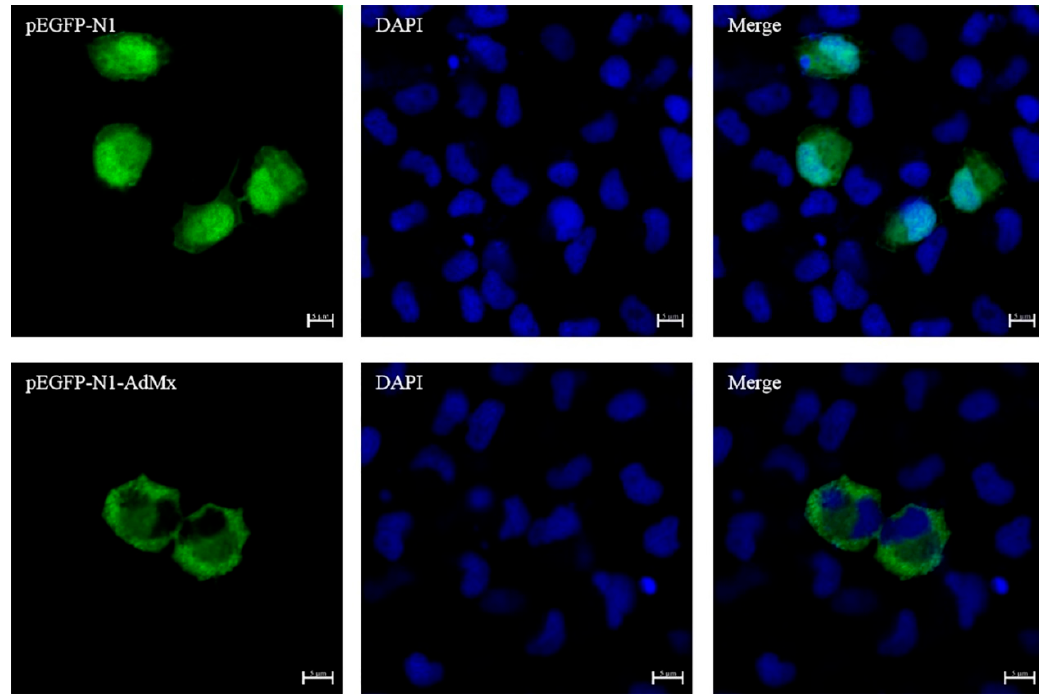
Figure 5. The mRNA expression pattern of AdMx in the spleen ( A ), kidney ( B ), muscle ( C ) and GSM cells ( D ) at indicate times post GSIV infection. The expression level of AdMx was determined by quantitative real time PCR (qRT-PCR) and all data were normalized to β -actin. For the convenience